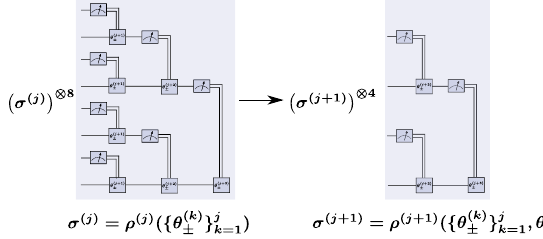
FIG. 6. Schematic circuits of a pooling-based QCNN. The left module belongs to the layer that acts prior to one which contains the right module. As shown, after each pooling layer, half the qubits are measured. In this special case, the unitaries in the convolutional and fully connected layers of the QCNN act